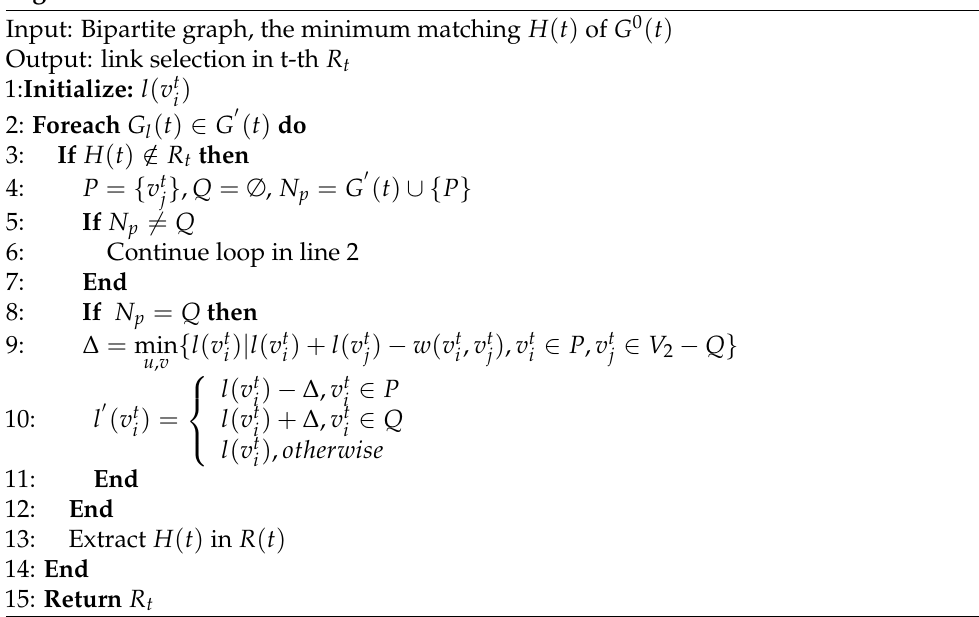
Algorithm 3 KM-based Link